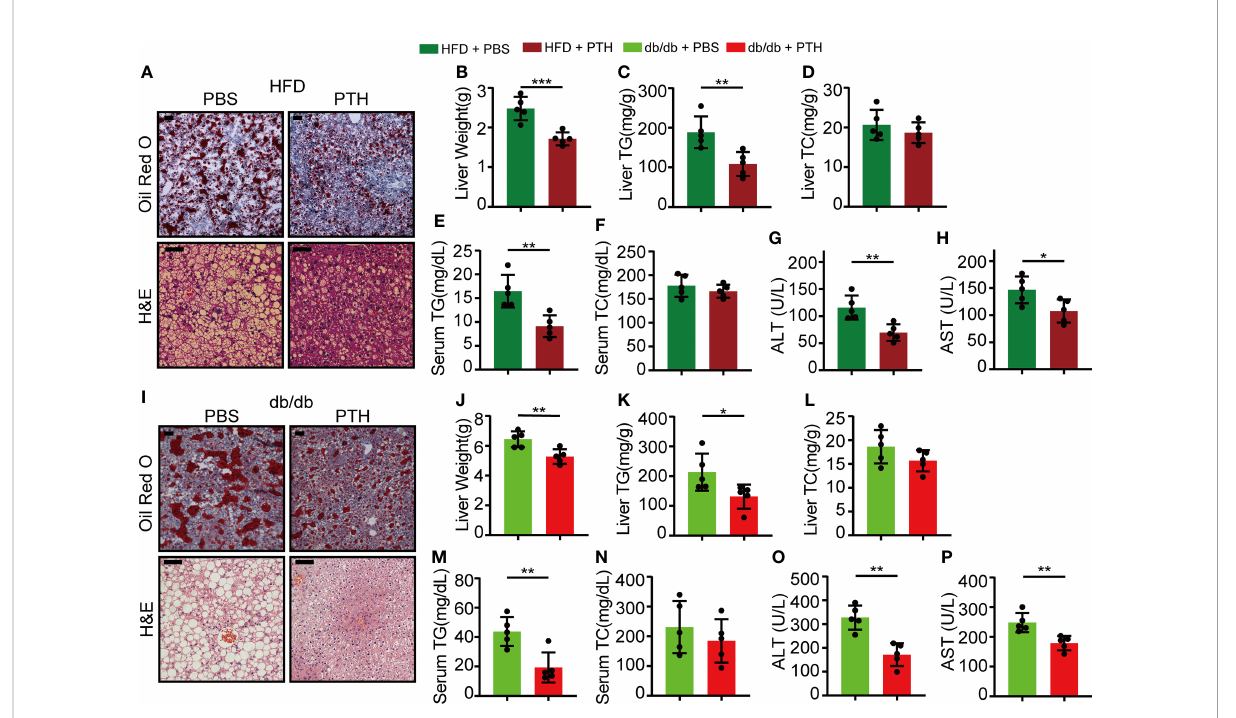
FIGURE 2 PTH alleviated hepatic steatosis in DIO mice and db/db mice. (A) The Oil Red O and H&E staining of liver tissues in DIO mice (Scale bar = 100 m m). (B) Liver weight. (C, D) The hepatic TG and TC levels. (E, F) The serum TG and TC levels. (G, H) The serum ALT and AST levels. (I) The Oil Red O and H&E staining of liver tissues in db/db mice (Scale = bar 100 m m). (J) Liver weight. (K, L) The hepatic TG and TC levels. (M, N) The serum TG and TC levels. (O, P) The serum ALT and AST levels. Data are shown as mean ± SD (n=5/group). *p < 0.05; **p < 0.01; ***p < 0.001 by two-tailed Student ’ s